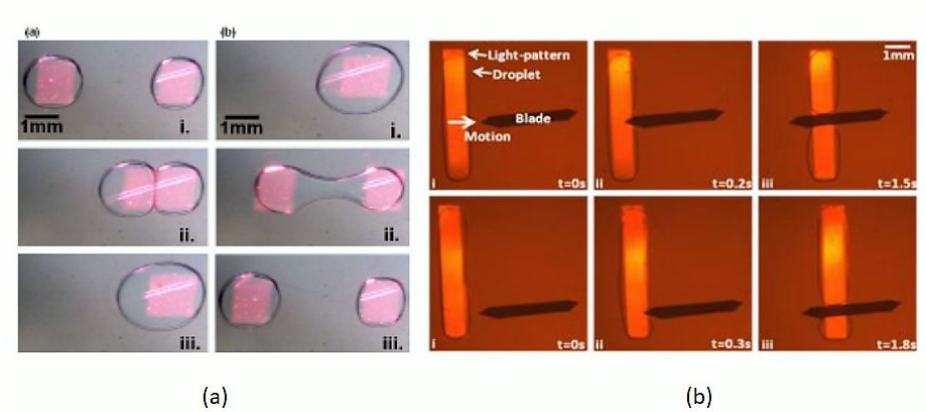
Figure 6. Optical droplets merging and sorting: ( a ) Square-shaped projection patterns moving two droplets towards each other, merged, and sliced back to acquire two droplets. Reproduced with permission from [135]; ( b ) Time sequences of an elongated droplet sliced by on-chip Teflon blade, droplet motion assisted by line projection. Reproduced with permission from [136].